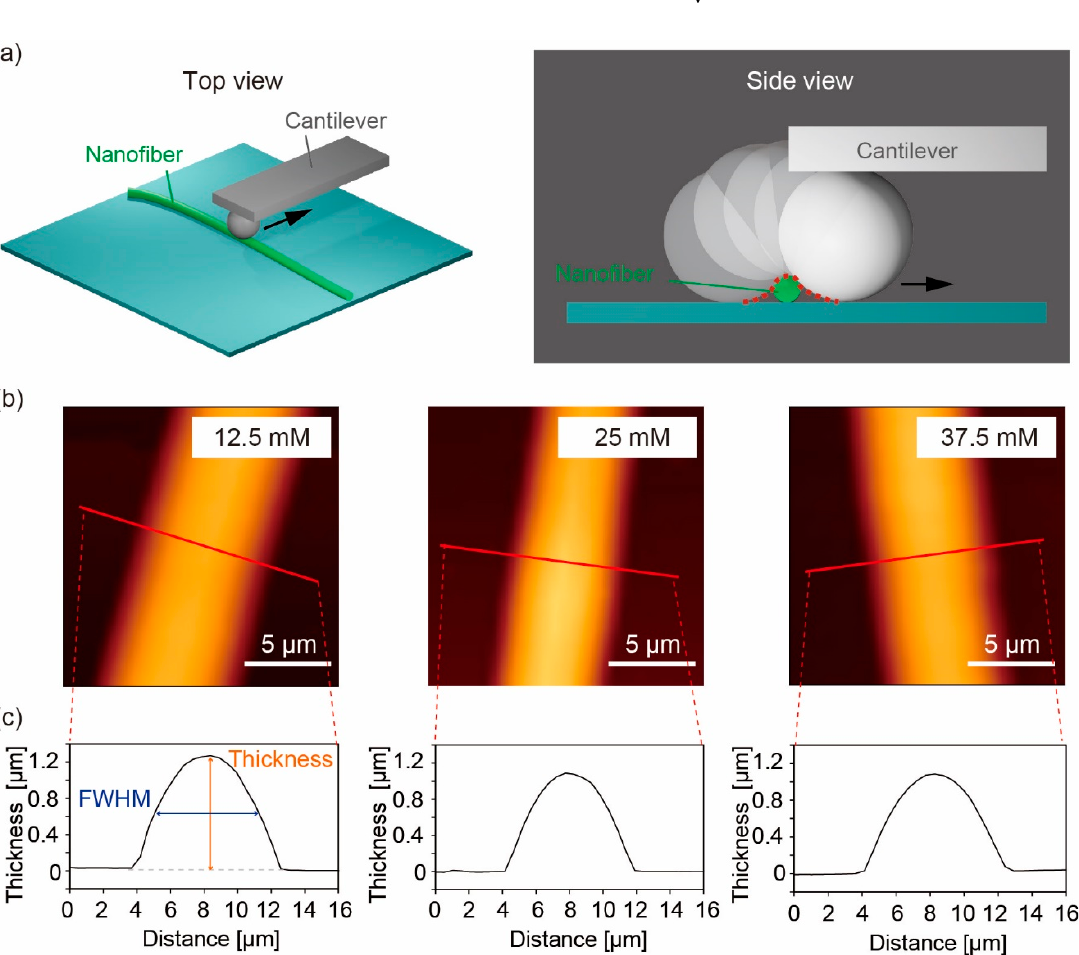
Figure 4. Topographic profiles of a single gelatin- β CD-Ad fiber using particle-assisted AFM prior to nano-indentation. ( a ) Schematic illustration of particle-assisted AFM. A topographic scan is essential to find the center of each fiber. ( b ) Height and ( c ) line profiles of a single gelatin- β CD-Ad fiber prepared in [ EDC ] = [ NHS ] = 12.5 mM, 25.0 mM, and 37.5 mM.